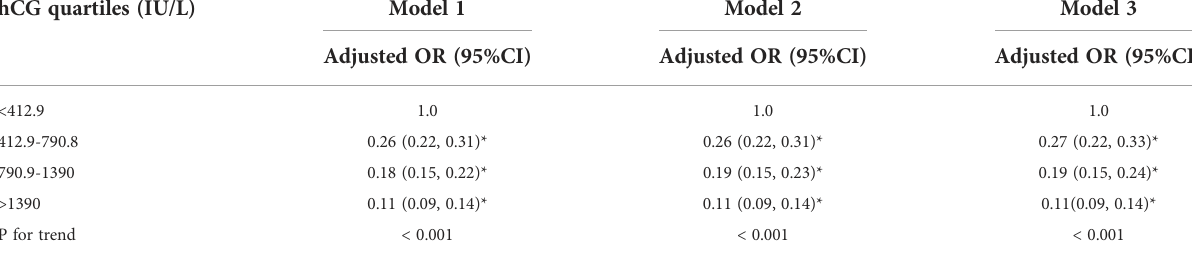
TABLE 3 The association between b -hCG level and the risk of early pregnancy loss occurrence.